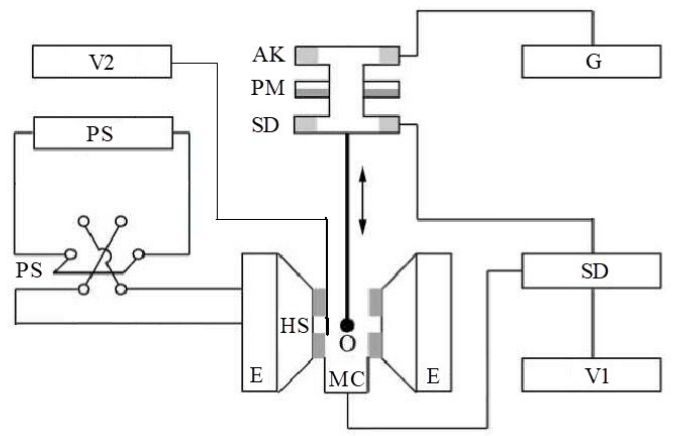
Figure 20. Electrical scheme of a vibrating magnetometer: PS is a electromagnet power supply with a polarity switch; HS is a Hall sensor; E is an electromagnet; MC are the measuring coils; AK is a coil for measuring amplitude; PM is a permanent magnet; G is a generator; SD is a synchro detector; V1 and V2 are the voltmeters; O is a sample.